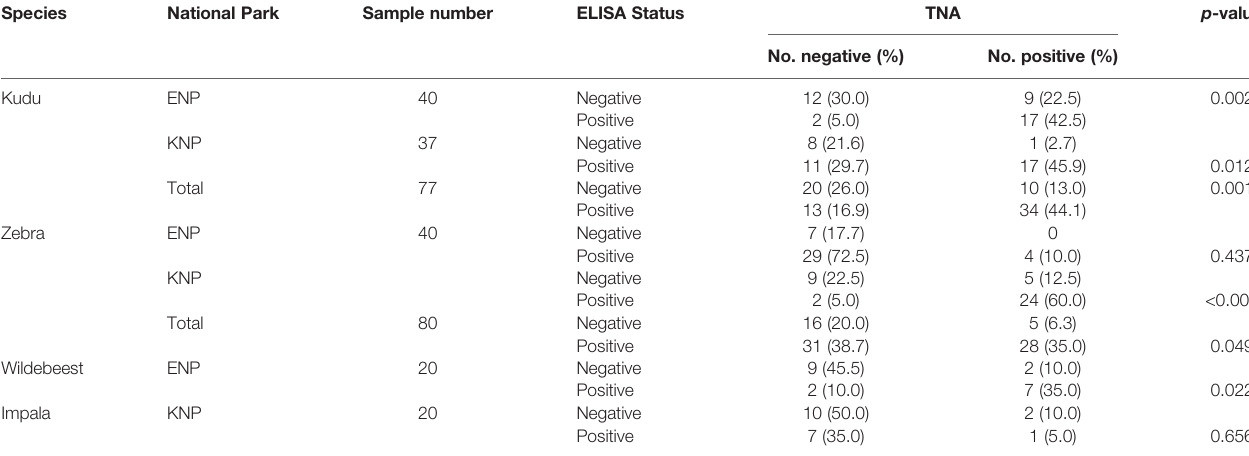
TABLE 3 | Comparison of anti-protective antigen (PA) enzyme-liniked immunosorbent assay (ELISA) and toxin neutralization assay (TNA) for the detection of immune exposure to B. anthracis in kudu, zebra, wildebeest and impala from Kruger (KNP) and Etosha (ENP) National Parks in South Africa and Namibia, respectively.